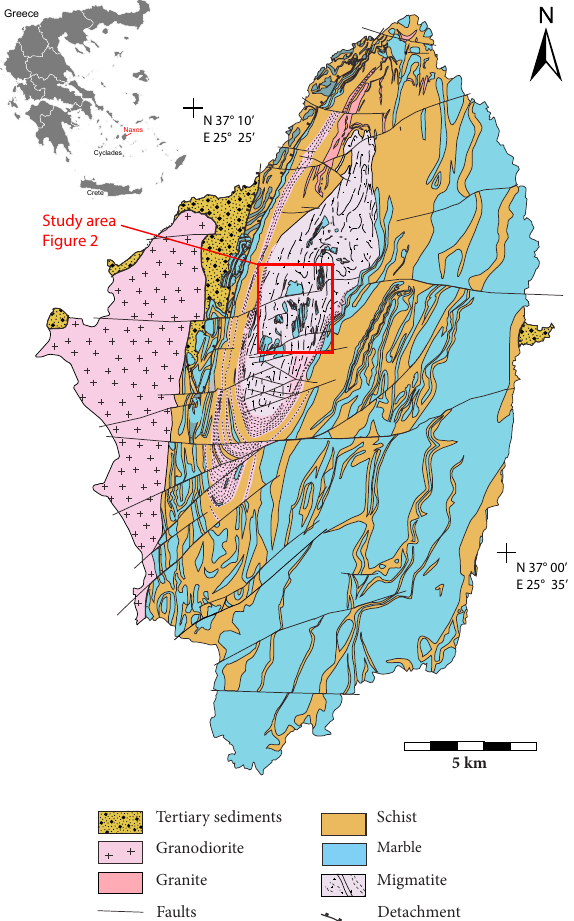
Figure 1. Geological map of Naxos, modified after Jansen (1993), Vanderhage (2004) and Kruckenberg et al. (2011). The study area (red box) is located in the central migmatitic core of the Naxos metamorphic core